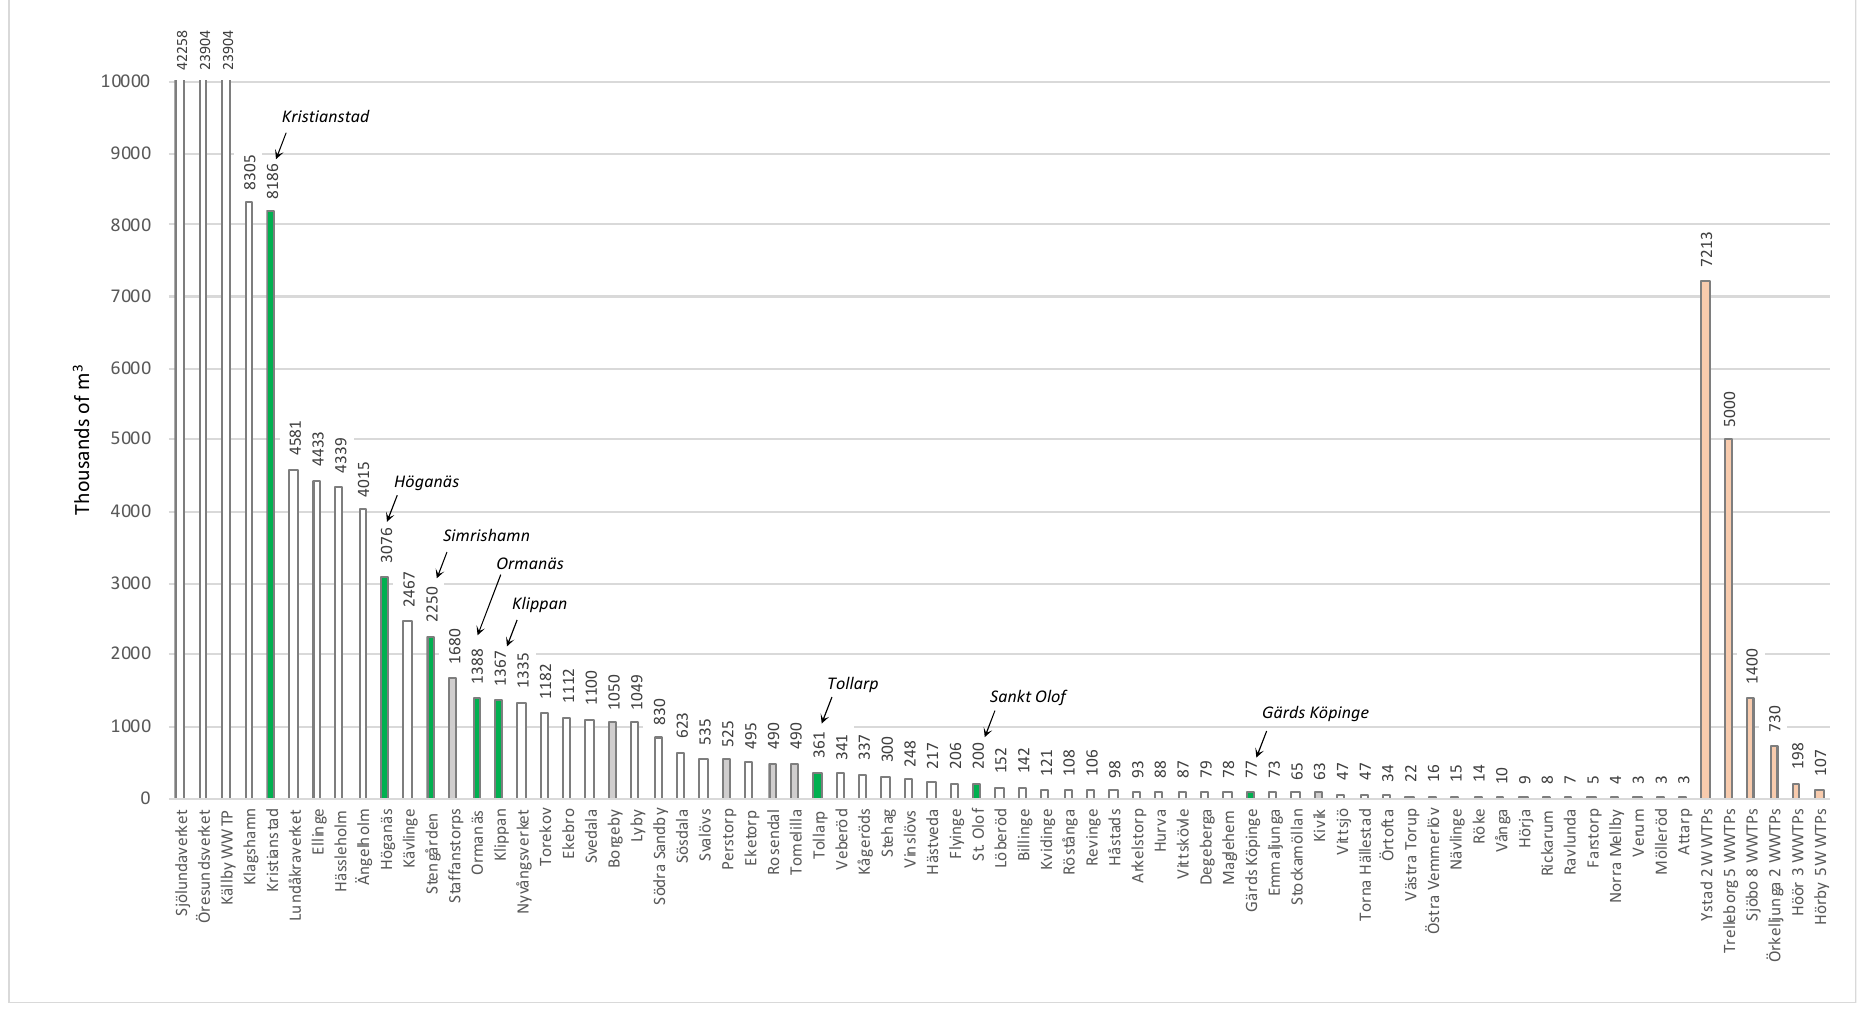
Figure 8. Yearly volume treated wastewater in thousands of m 3 in County Scania. For explanations, see text.